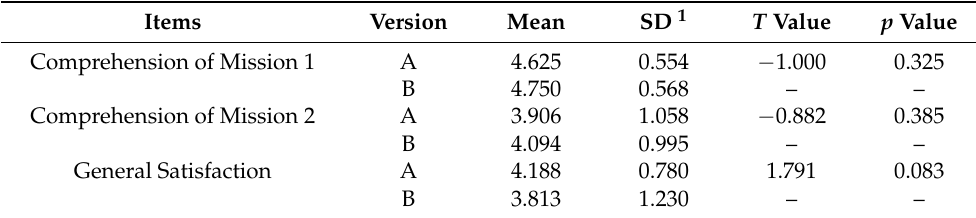
Table 4. The understandability of navigation